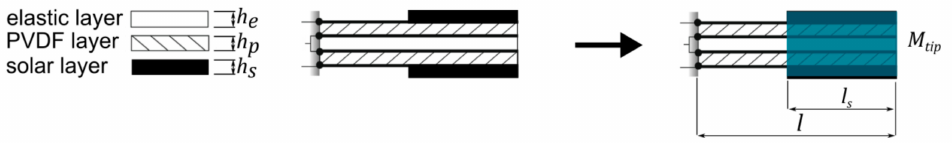
Figure 7. Second modelling approach used in the current study where solar panels are represented as a distributed tip mass. Tip mass is highlighted in